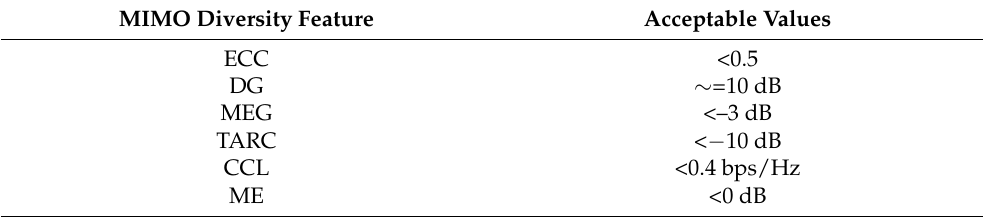
Table 4. MIMO diversity parameter